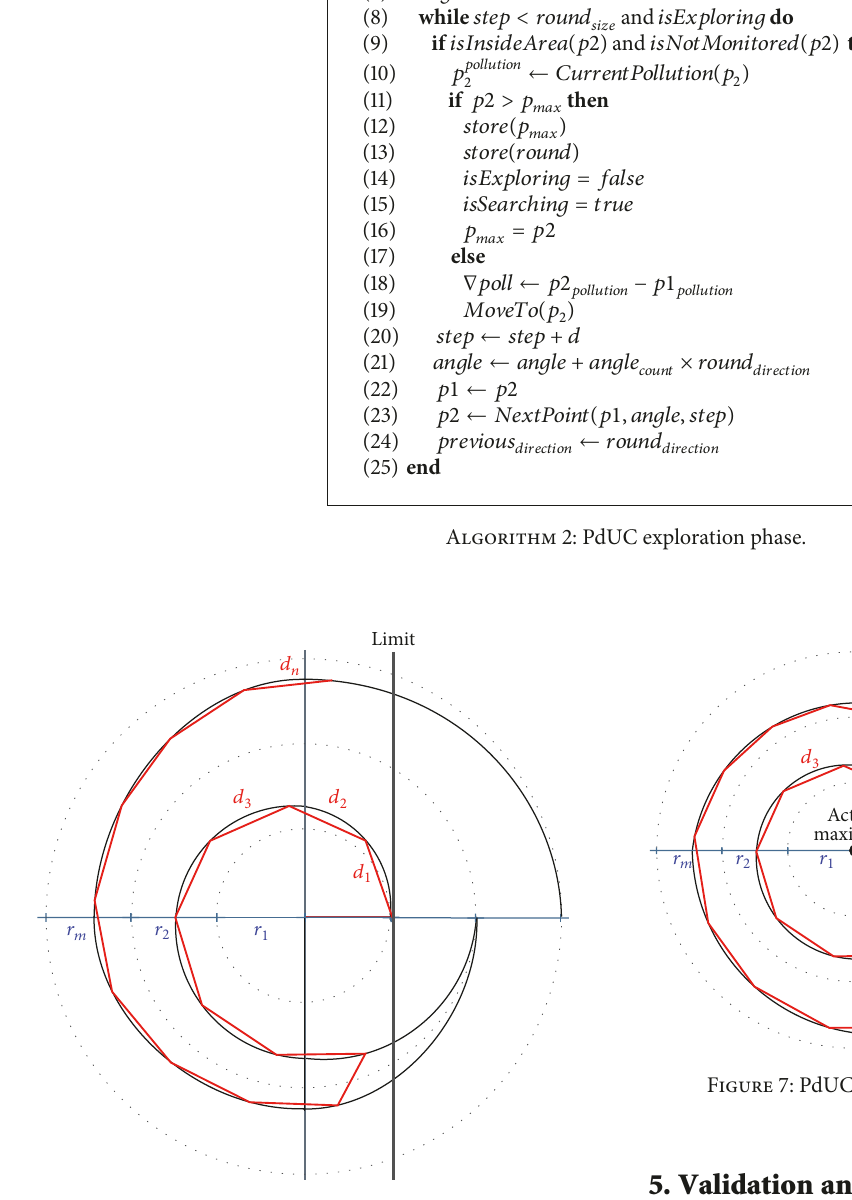
Figure 6: PdUC algorithm: alternating spiral direction.